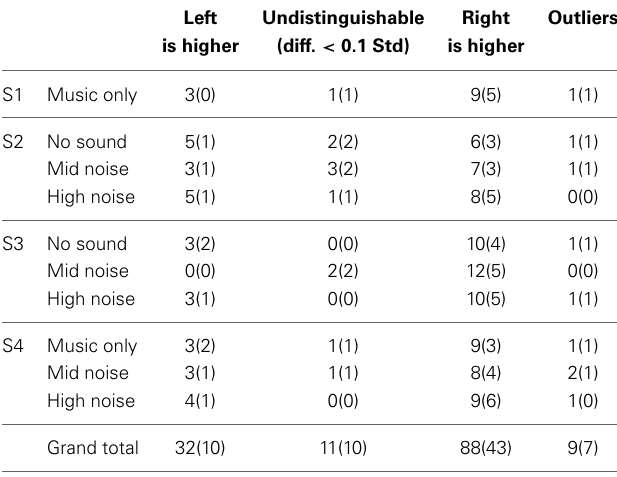
Table 3 | Statisics of hemispheric lateralization (from Table 2). Left Undistinguishable Right Outliers